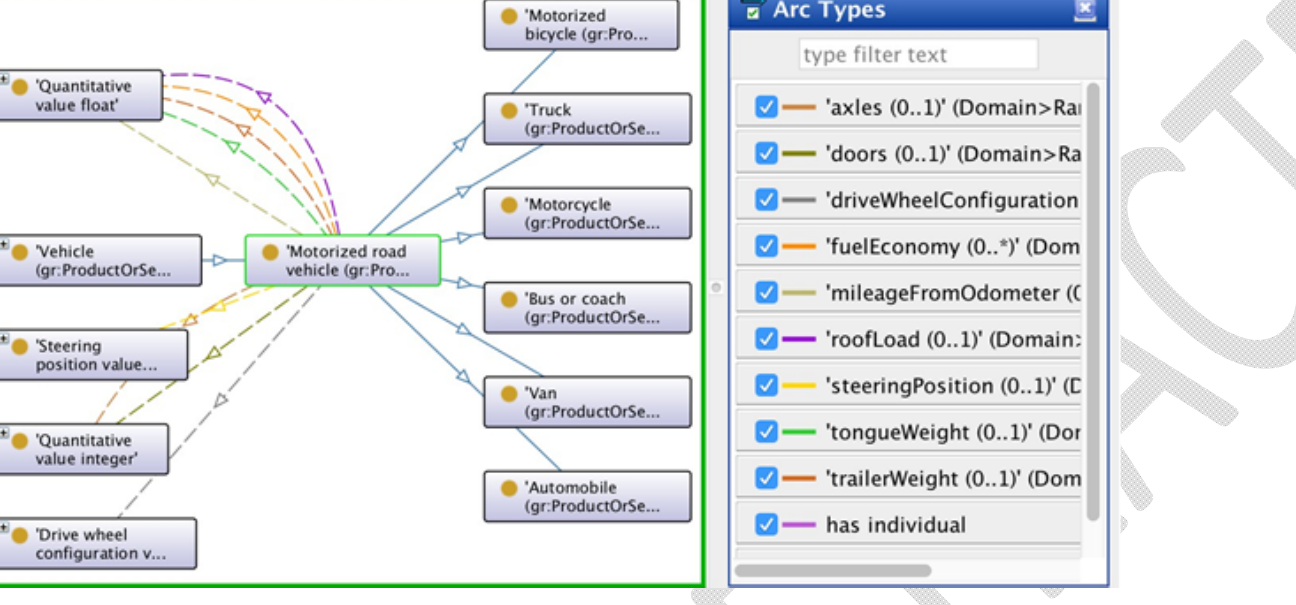
Fig. 1. Representation of Good Relations between Products and Ontology Services (Hepp,